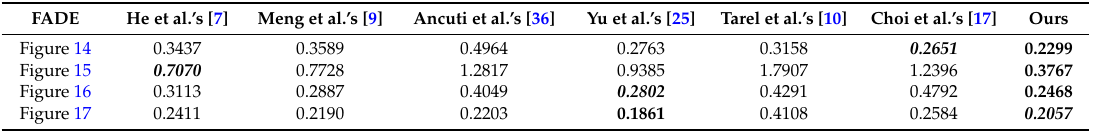
Table 4. Comparison of fog-aware density evaluator (FADE) for the dehazing results obtained via different methods.